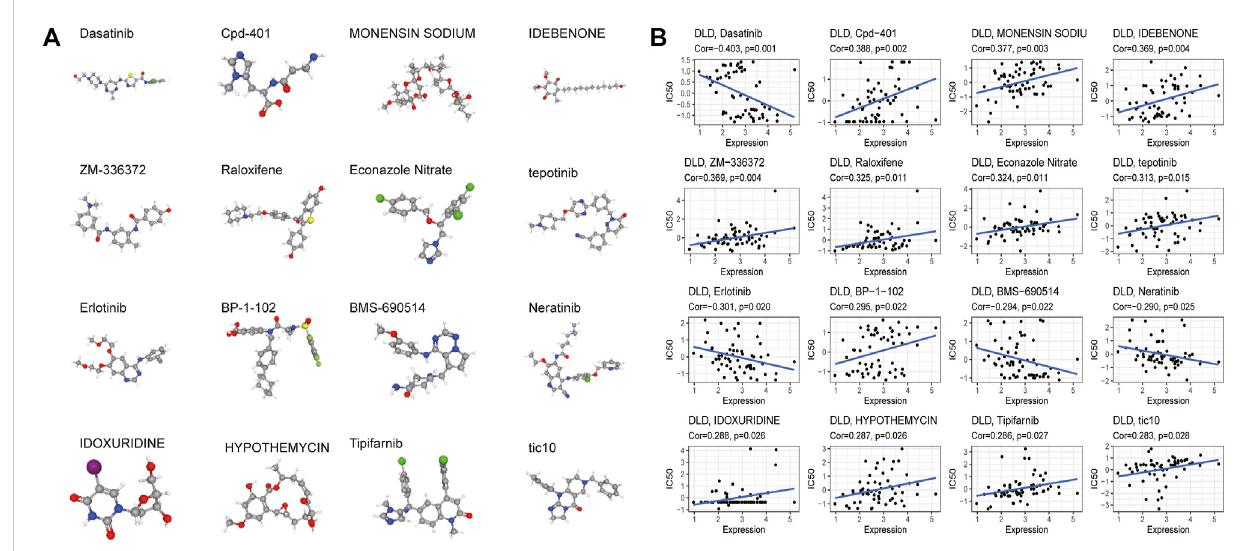
FIGURE 14 Drug sensitivity analysis. (A) 3D structure of the screened drugs. (B) Relationships between the DLD gene and sensitivity to antitumor